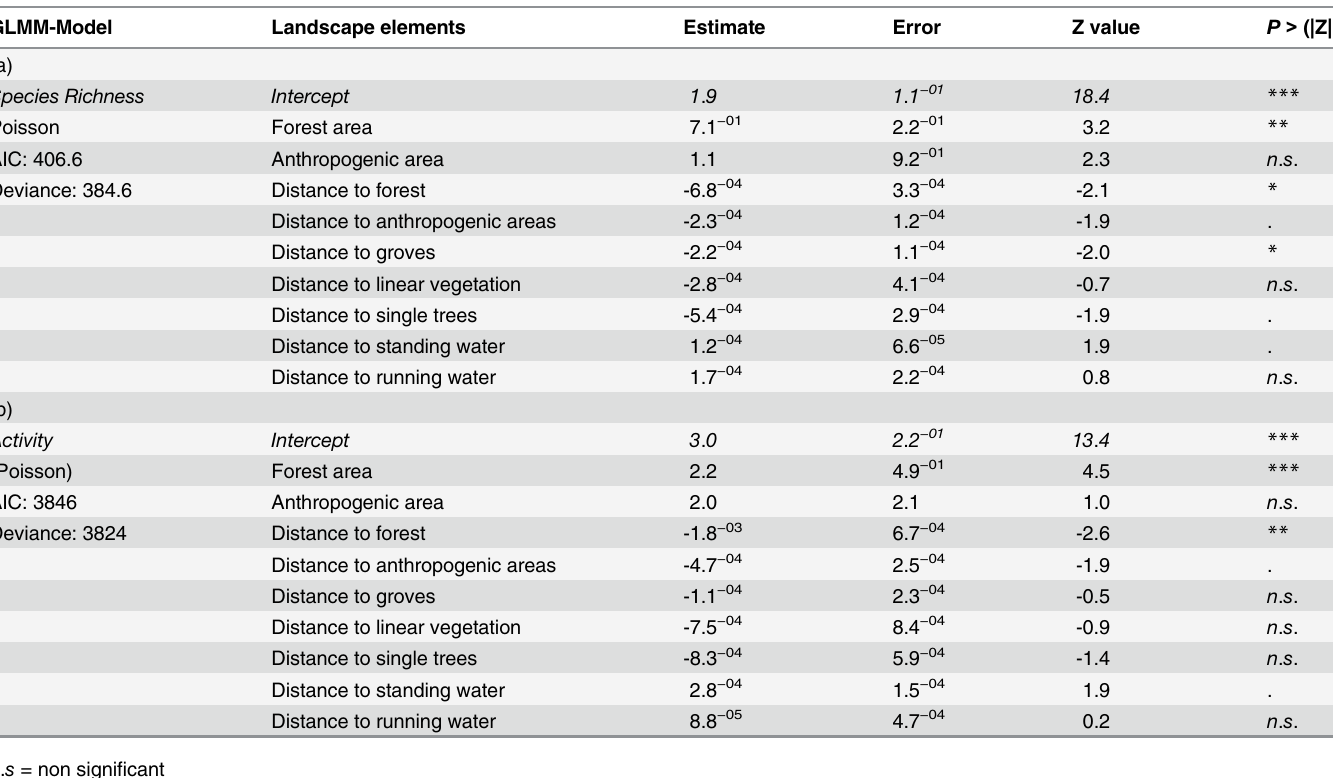
Table 1. Statistical results of the Poisson distributed generalized linear mixed effect models (GLMM). Presented are landscape elements and their respective effect on bat occurrence and bat activity on grassland recording sites in the Schorfheide-Chorin.